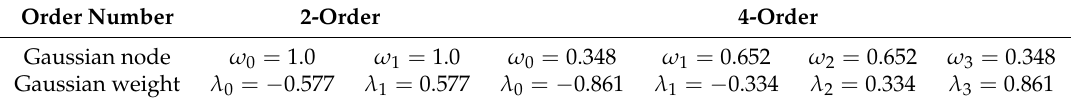
Table 1. Gaussian node and weight for two-order and four-order Gaussian quadrature. Order Number